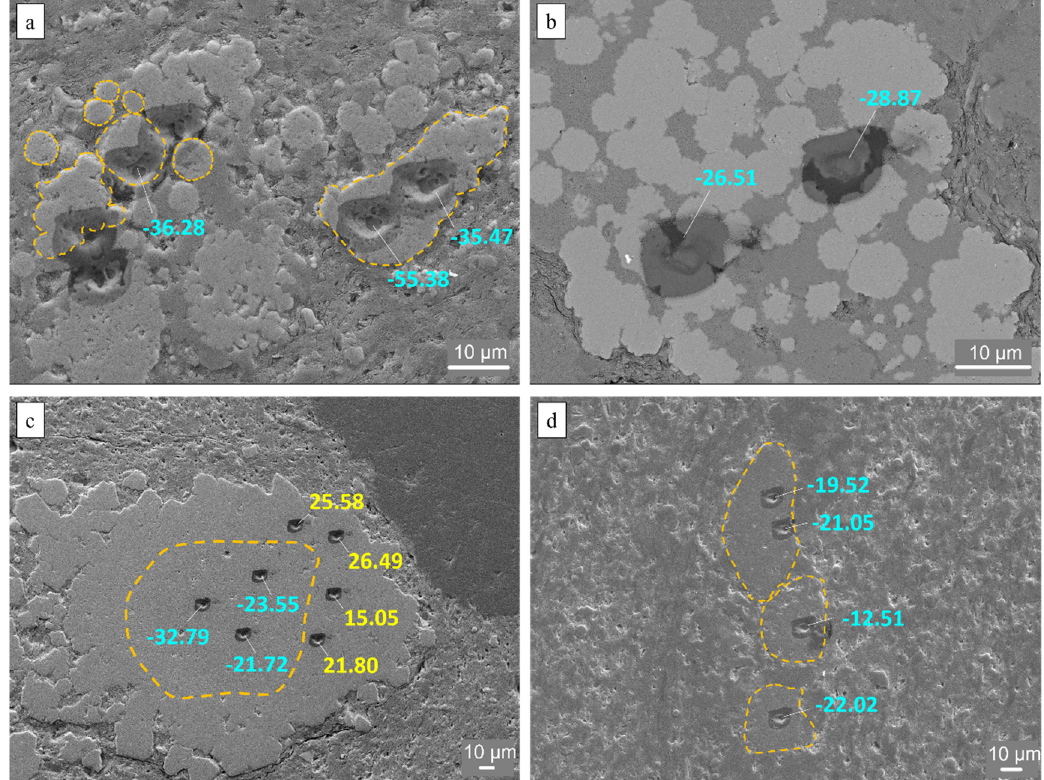
Figure 6. SEM images with δ 34 S values in the pyrites of different morphologies: ( a , b ) Aggregates of small pyrite framboids; ( c ) Aggregate of large euhedral pyrite crystals—dashed line shows the boundary between positive and negative parts of the aggregate in terms of dS34; and ( d ) Consolidated aggregates of framboids or small pyrite crystals.